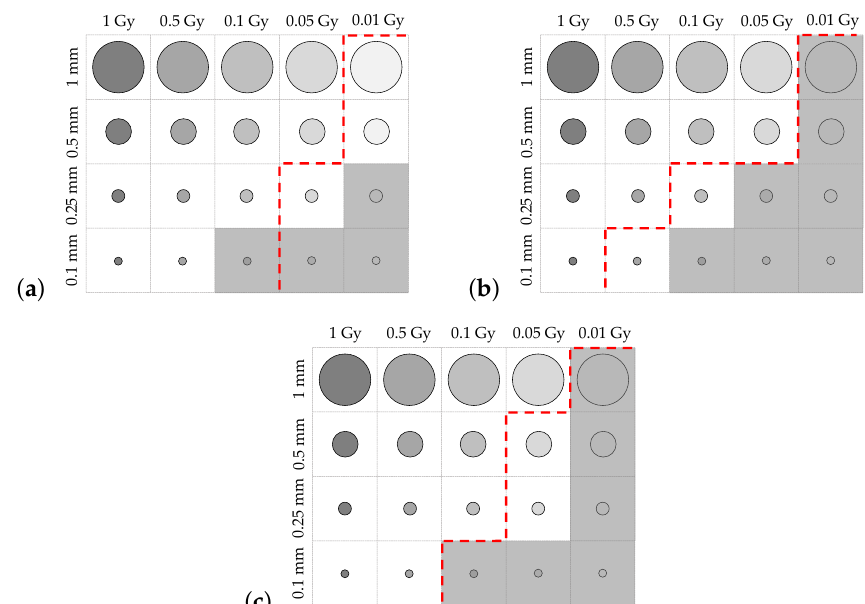
Figure 14. Comparison of contrast-detail plots for the miniaturised dosimeter with: ( a ) no uncertainties; ( b ) simulated atmospheric turbulence; ( c ) simulated mechanical vibrations. Greyed-out regions indicate voxels that could not be distinguished. Red lines indicate the boundary of distinguishable voxels for each uncertainty simulation on the nonminiaturised